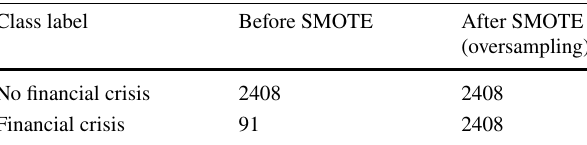
Table 4 The count of samples in the used dataset before and after SMOTE